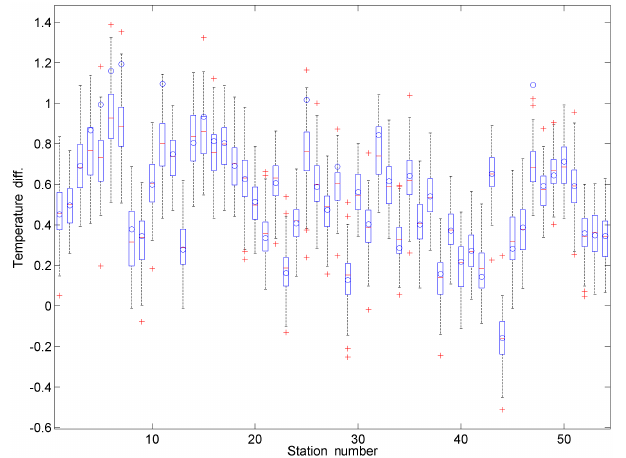
Figure 3. Annual mean temperature difference ( ◦ C) between the validation period (1994–2008) and the test period (1976–1993) for each station for the IBB-simulated data (box plot) and the observed data (circle). Boxes indicate the interquartile range (IQR), and whiskers extend to ± 1.5IQR. The horizontal lines inside the boxes depict the median of the data. Data beyond the fences ( ± 1.5IQR) are indicated by a plus symbol ( + ) , which represents outliers.